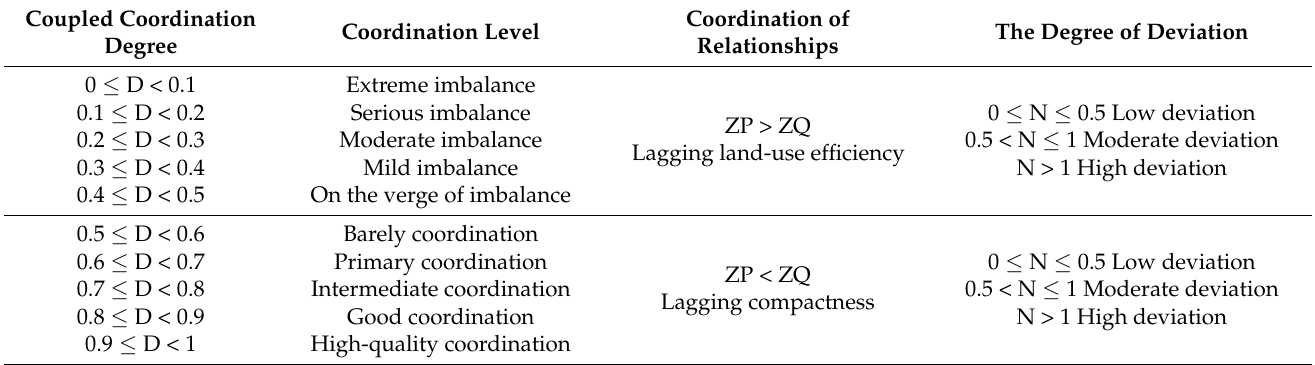
Table 4. The coordinated development state of the compactness and land-use efficiency and relationship delineation.